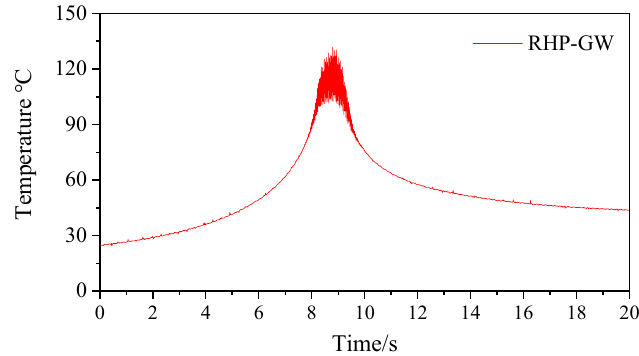
Figure 13. Grinding temperatures in the grinding contact zone.